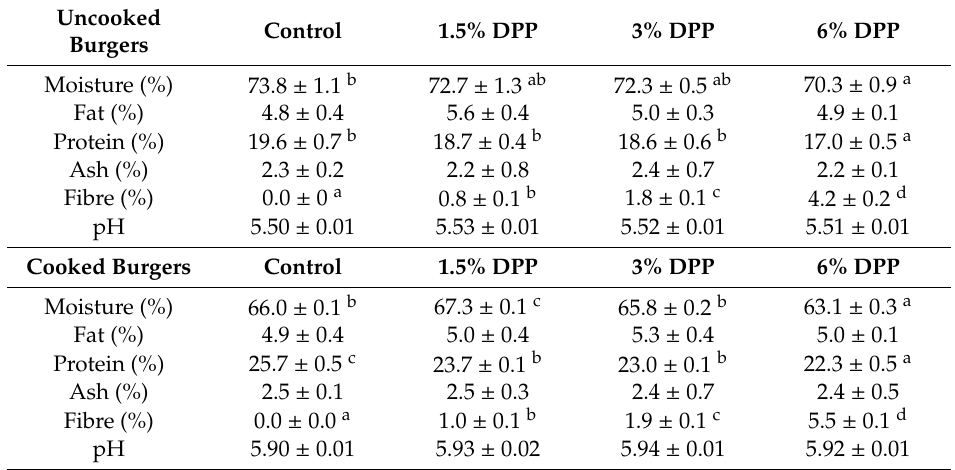
Table 2. Chemical analysis and pH of burgers (uncooked and cooked) with date pit